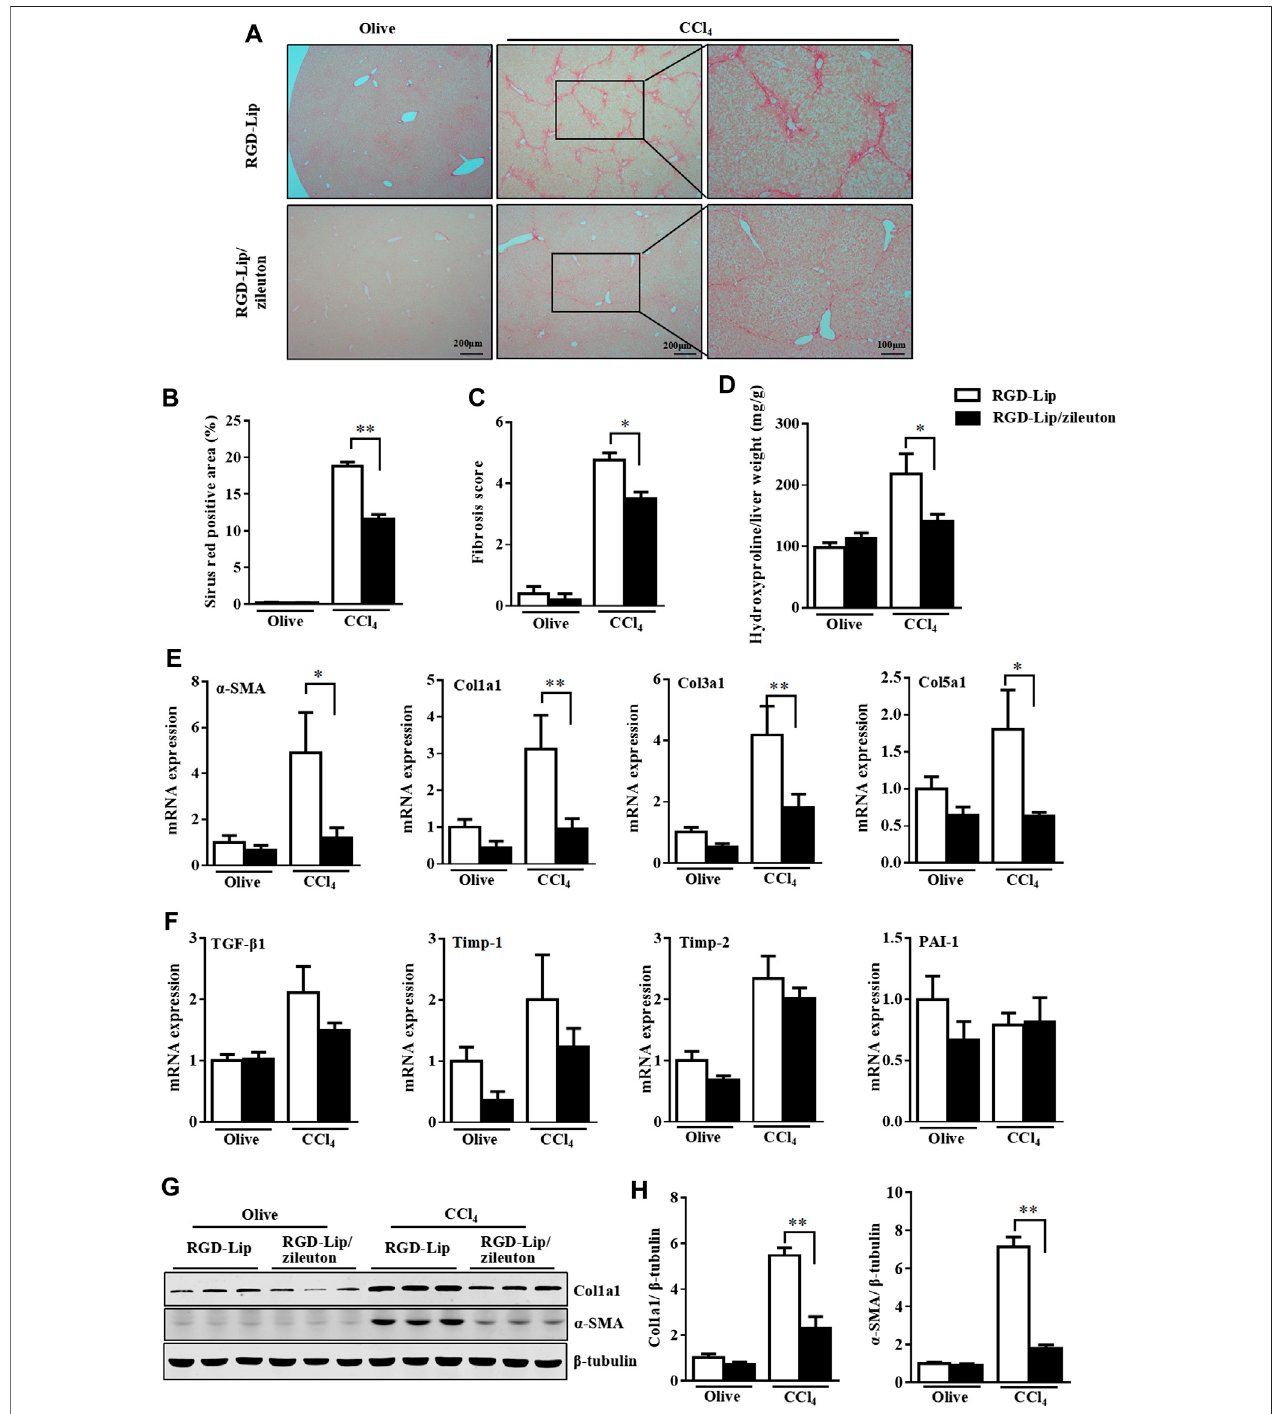
FIGURE 7 | Targeted delivery of zileuton to HSC is ef fi cient against CCl 4 -induced liver fi brosis. WT mice were treated with olive oil or CCl 4 for 8 weeks. During the last 4 weeks, mice given RGD-Lip or RGD-Lip/zileuton (10 mg/kg) every 3 days by tail vein injection. (A,B) Liver sections were collected for picrosirius red staining. (C) Fibrosisscore wasassessed for collagen according tothe Ishak criteria. (D) Detection ofhepatic hydroxyproline level. (E,F) qRT-PCR analysis ofmRNA levels of fi brotic genes in livers of 4 groups. (G) Western blot analysis of the protein levels of α -SMA and Col1a1. Data are mean ± SEM, n (cid:2) 7, * p < 0.05, ** p < 0.01.